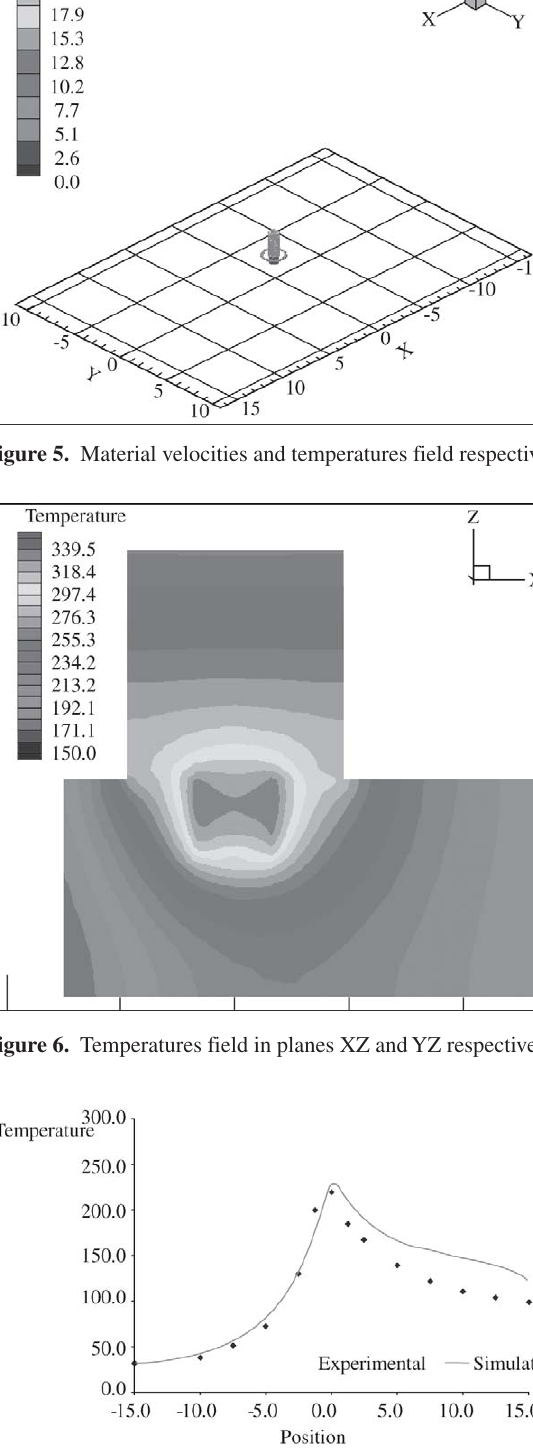
Figure 7. Experimental results compared to obtained in the simu-